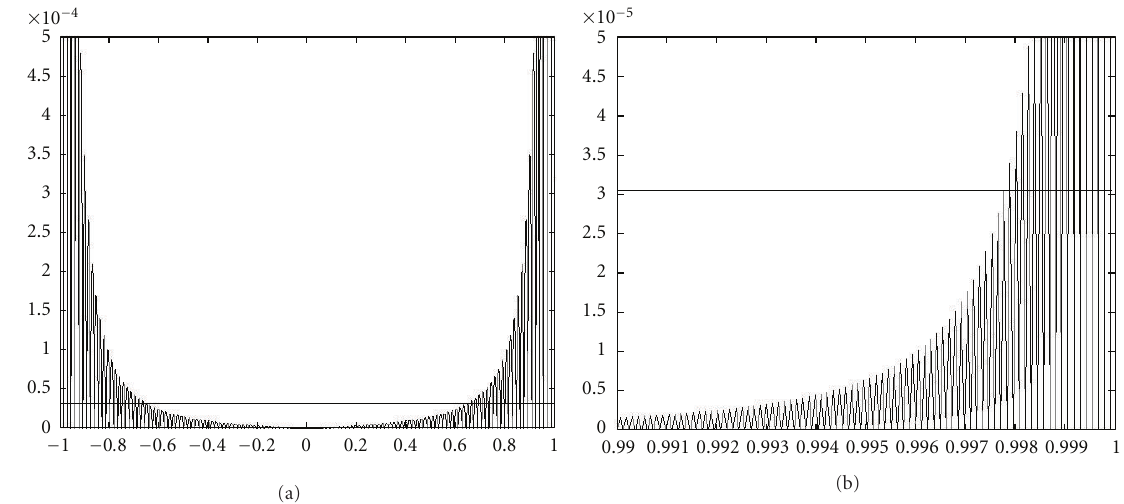
Figure 3: Absolute approximation error for two uniformly distributed sampling schemes ( f n = 128 for (a) and f n = 16384 for (b)).